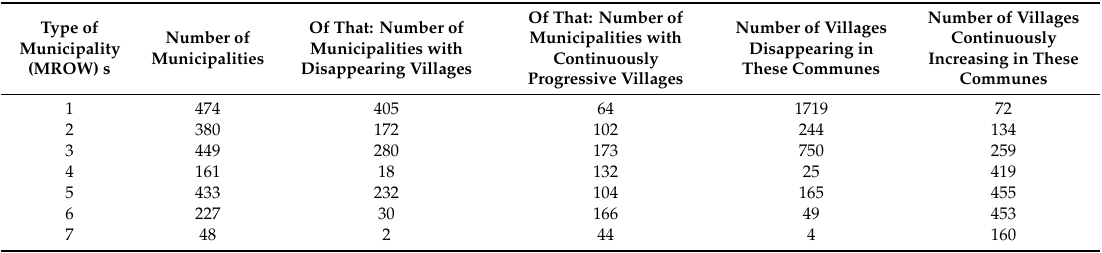
Table 3. Gminas with disappearing and progressive villages by type of socio-economic